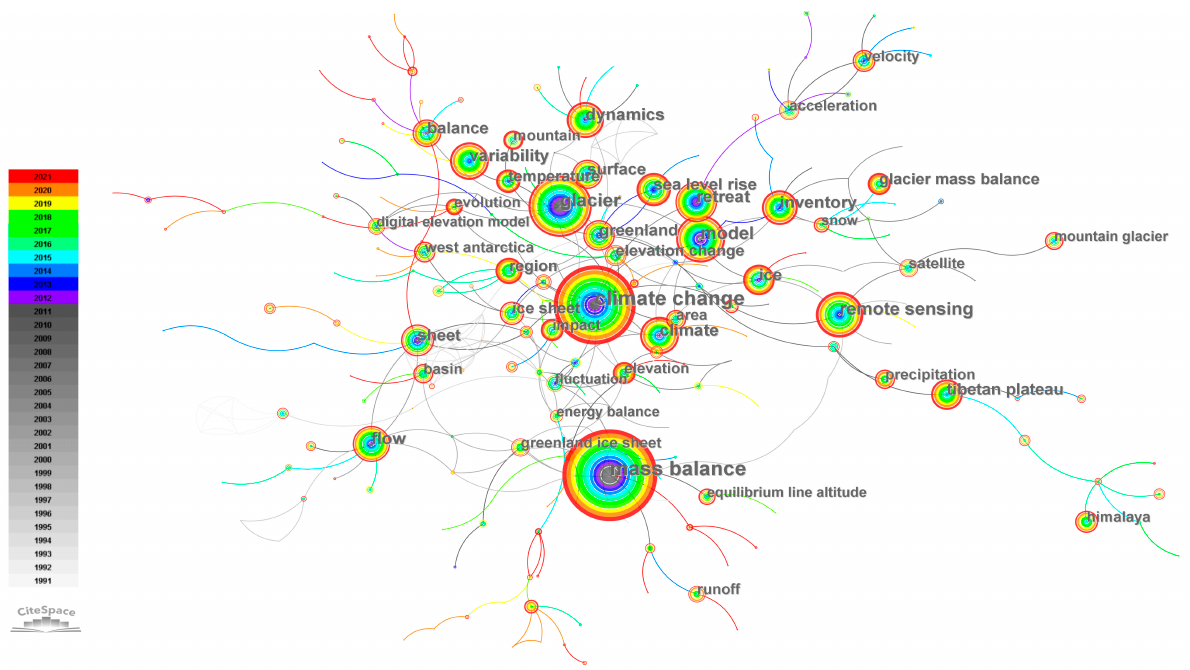
Figure 10. Keyword co-occurrence network analysis. In the network diagram, the size of the nodes represents the frequency of keywords, which can reflect the degree of attention in the research field.